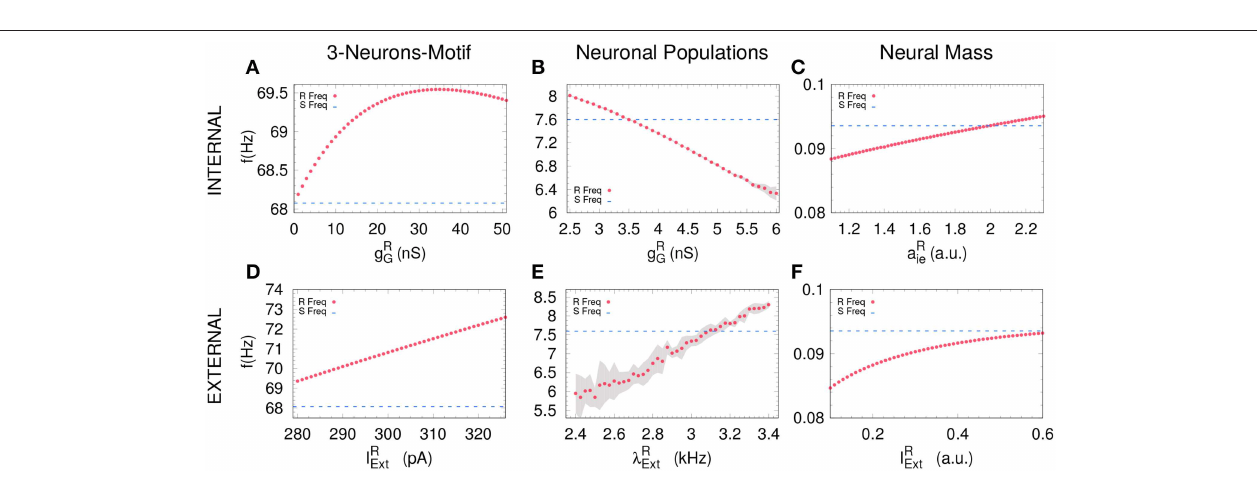
FIGURE 3 | Receiver free-running frequency. Assessing the free-running frequency of the receiver when uncoupled from the sender for all the models. (A–C) show how the receiver’s frequency changes when varying the internal parameter while (D–F) when changing an external parameter. Blue dashed line represents the sender’s natural frequency and magenta dots represents the receiver’s frequency. Gray shadow represents the standard deviation over 10 runs (see Methods). For the parameters used here see